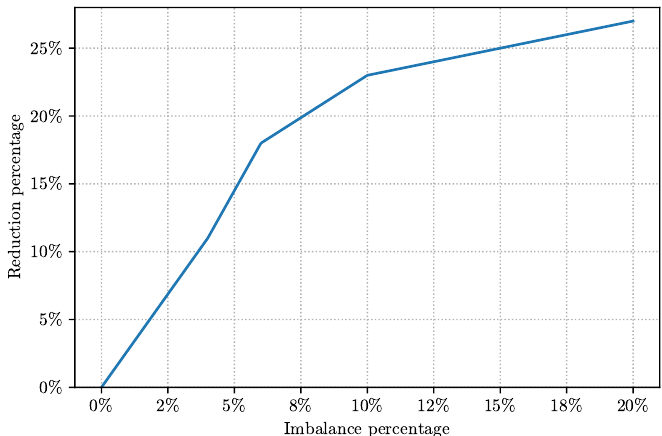
Figure 10. The percentage of improvement in cut value as we increase the allowable imbalance